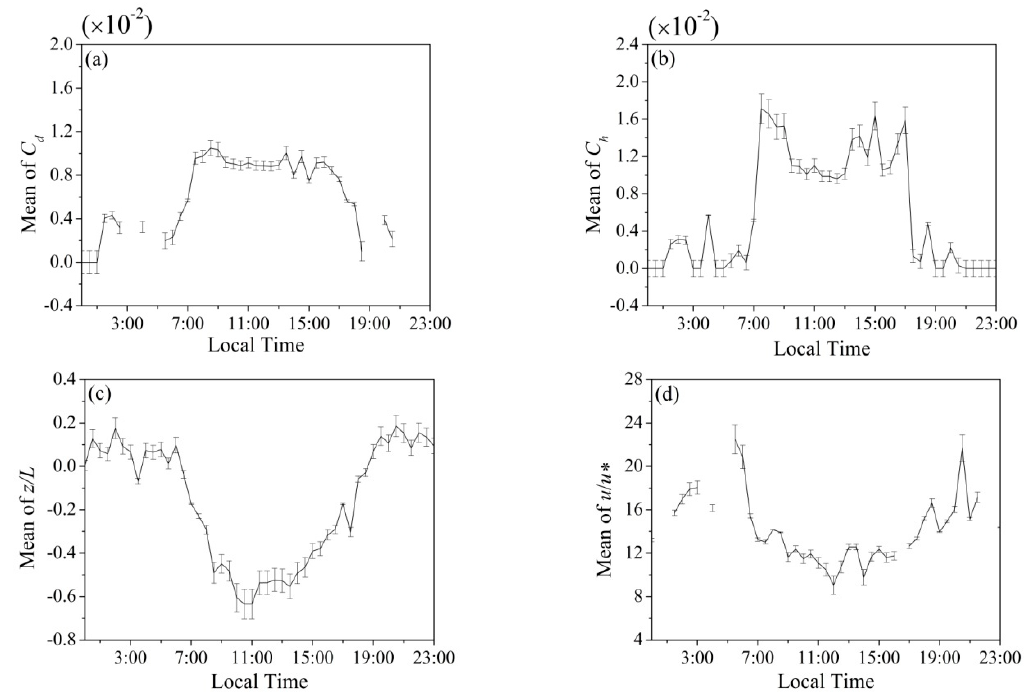
Figure 10. ( a ) Mean daily variation in C d , with wind directions of NNE–ESE from 5 January to 31 December 2010. ( b ) Mean daily variations in C h , with wind directions of NNE–ESE from 5 January to